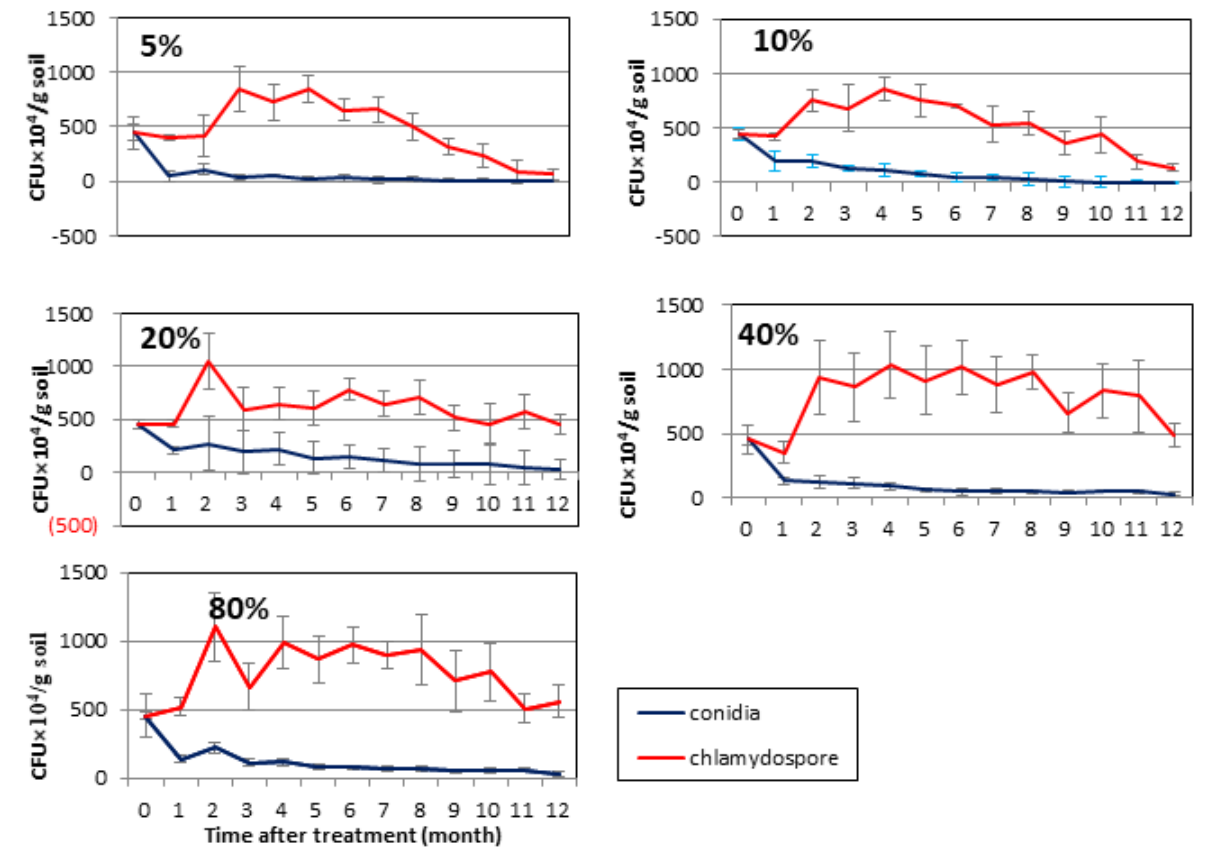
Figure 4. Comparison of Trichoderma longibrachiatum Tr58 content between conidia- and chlamydospore-amended soils with different moisture levels.